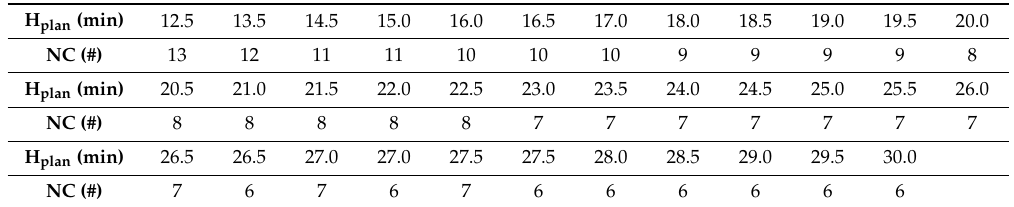
Table 1. Feasible service configurations.